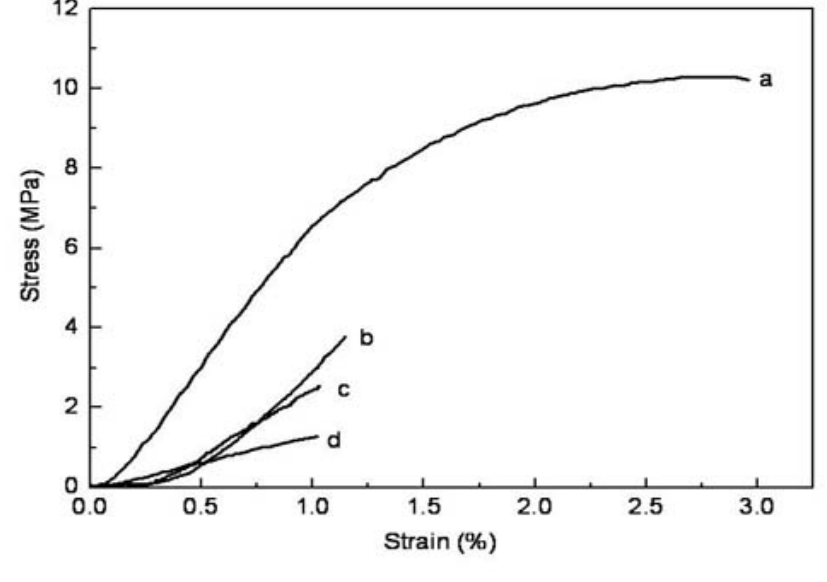
Figure 2. Tensile stress-strain curves of cross-linked CS/SF composite membranes with